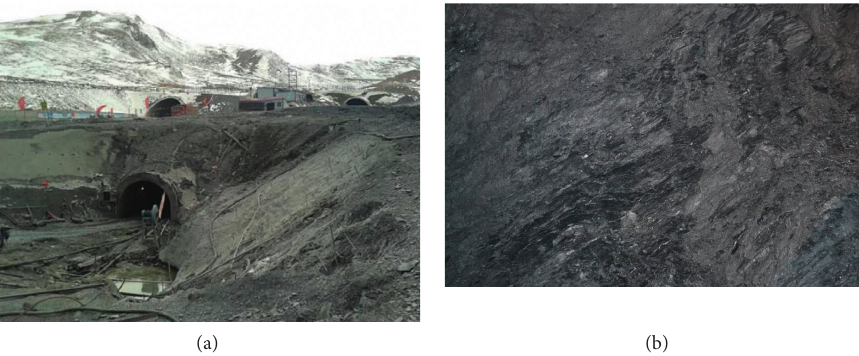
Figure 1: Jiangluling Tunnel. (a) Cross section of the tunnel entrance. (b) Photo of the surrounding rock at tunnel entrance face.